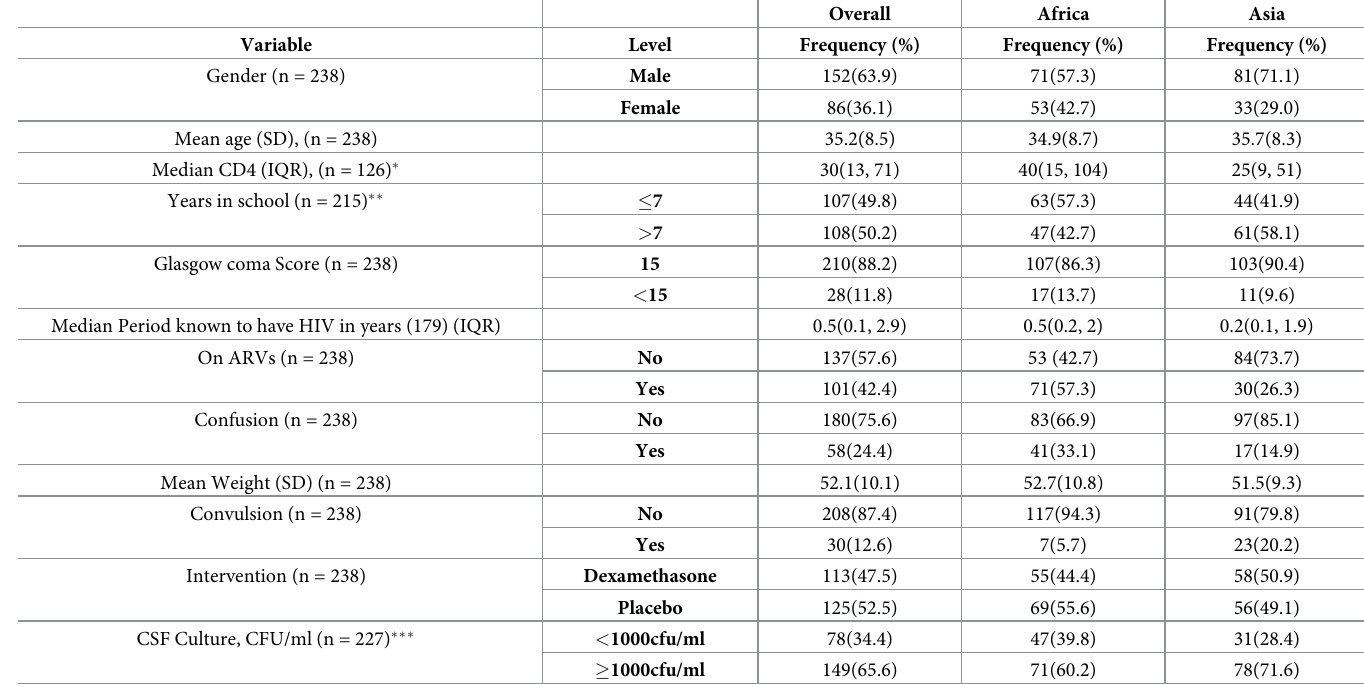
Table 1. Baseline characteristics of the patients that had QOL evaluation at 10 weeks.